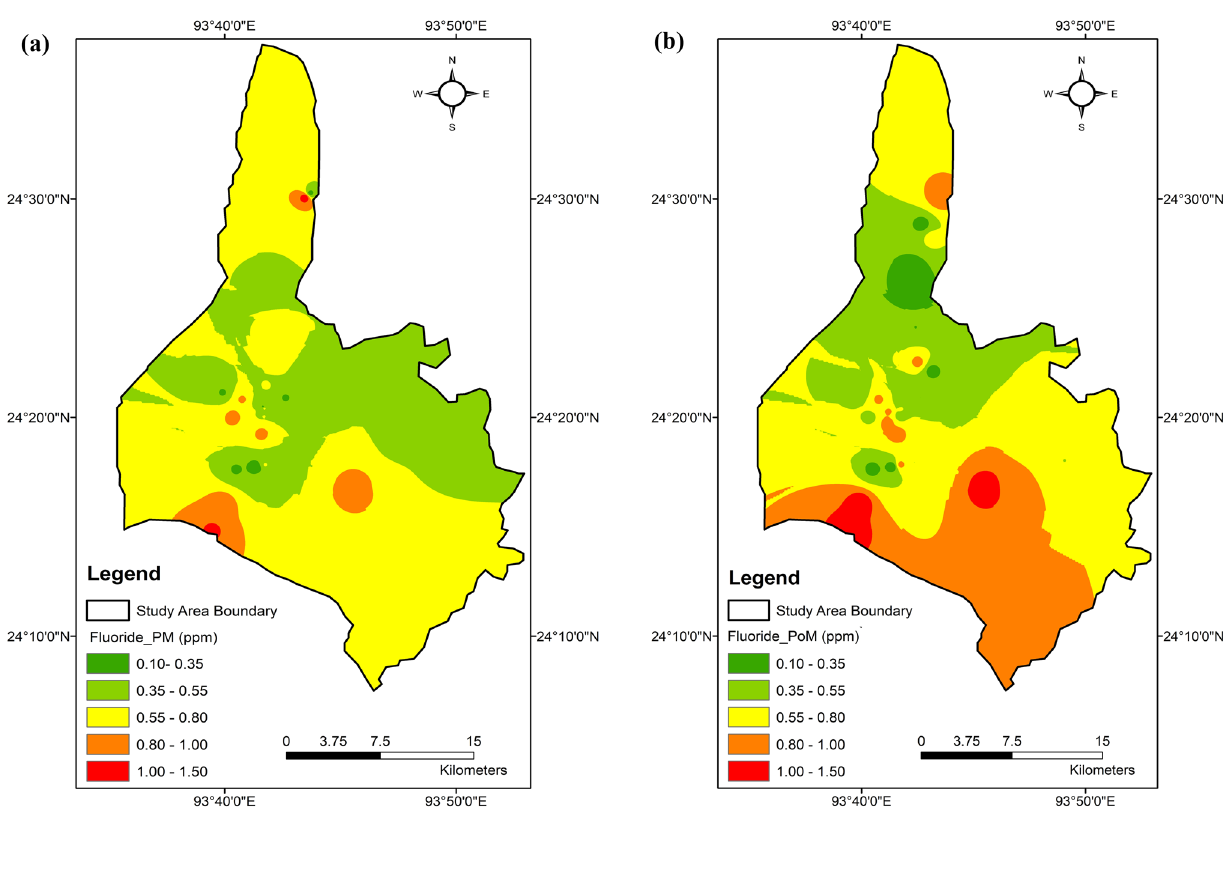
Fig. 2 The map showing the spatial distribution of fluoride concentration in the study area during a PM and b PoM seasons